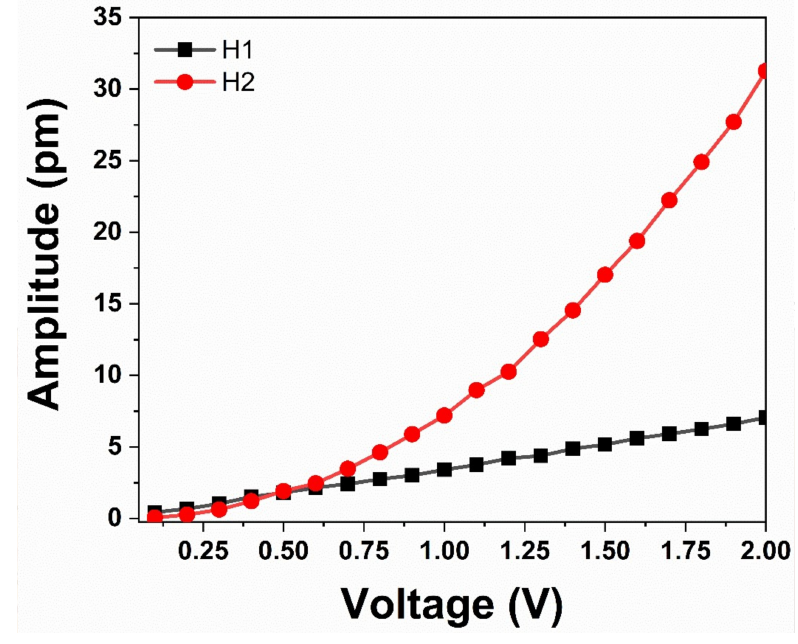
Figure 5. Values for the first and second harmonic of the PFM cantilever over the surface of HA.